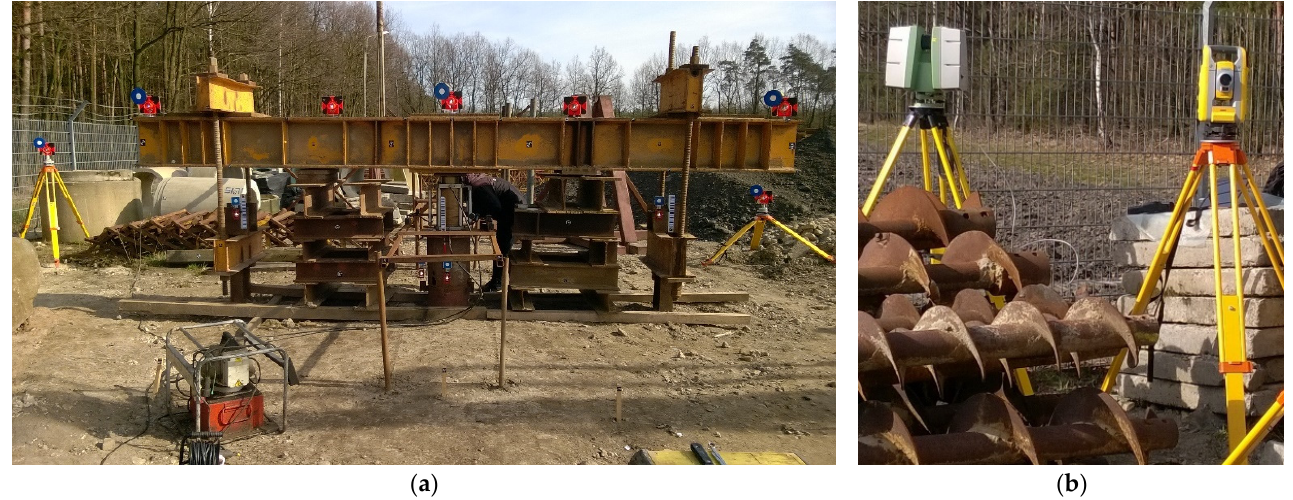
Figure 2. View of the test stand and instrumentation: ( a ) the SLT appliance with attached dial gauges, prisms for total station, and planar targets for scanner; and ( b ) the position of the laser scanner and total station right in front of the loading structures.